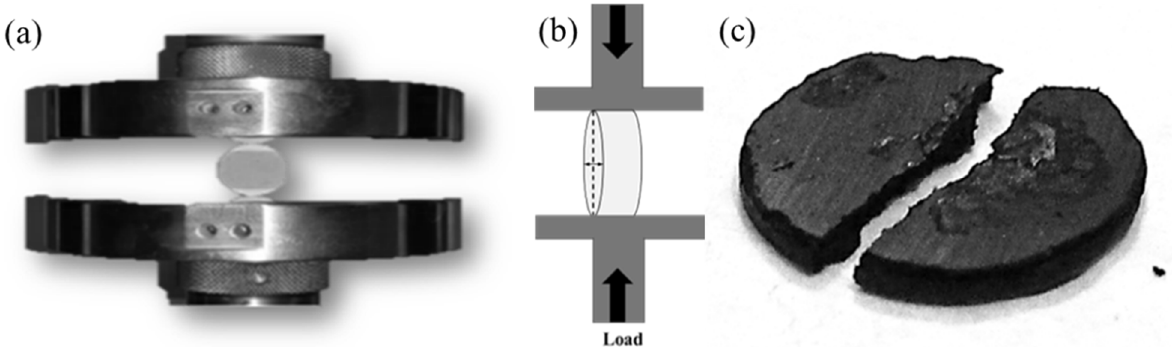
Figure 5. ( a ) Membrane mounted vertically between two flat plates of machine; ( b ) membrane squeezed along the diameter by applying external load; ( c ) failure of membrane across the diameter.